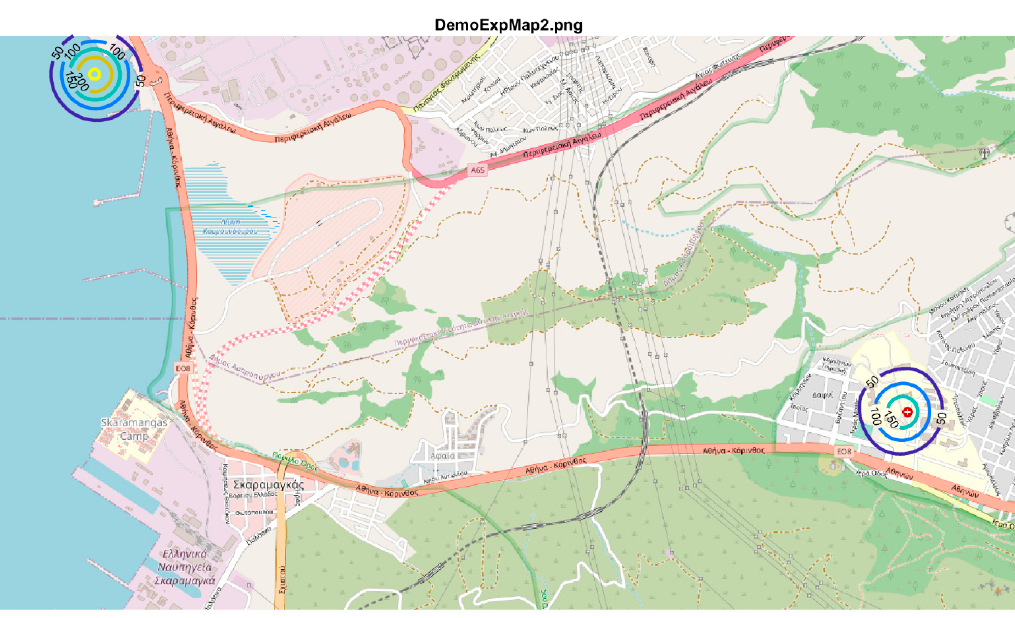
Figure 8. 2.5D isolines visualization.